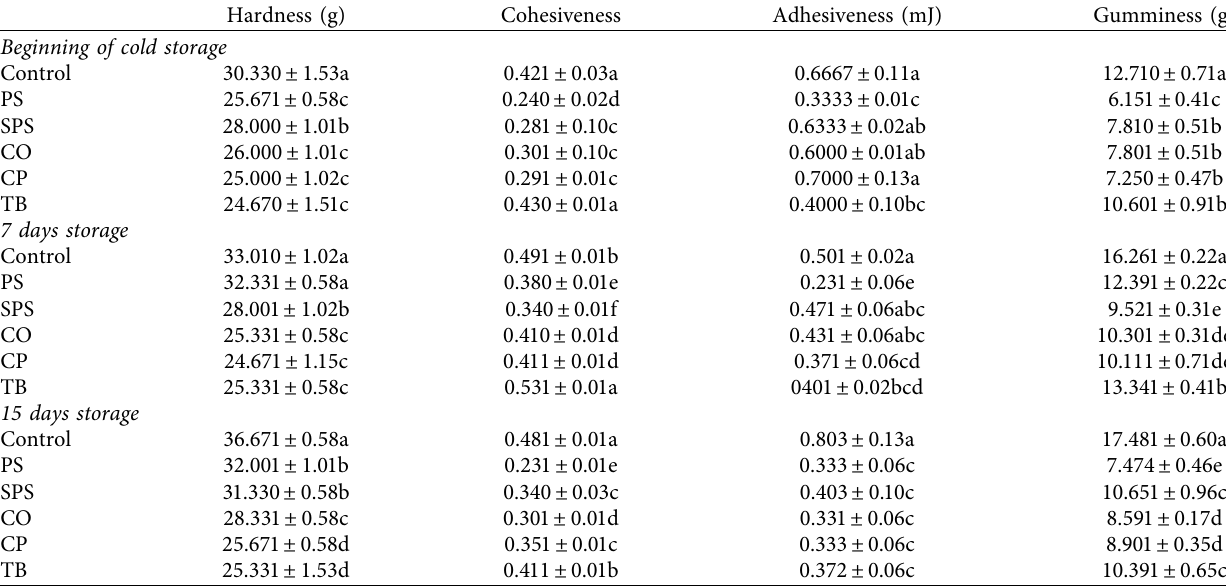
Table 2: Effect of okra gum and starches addition on texture of yogurt after 0, 7, and 15